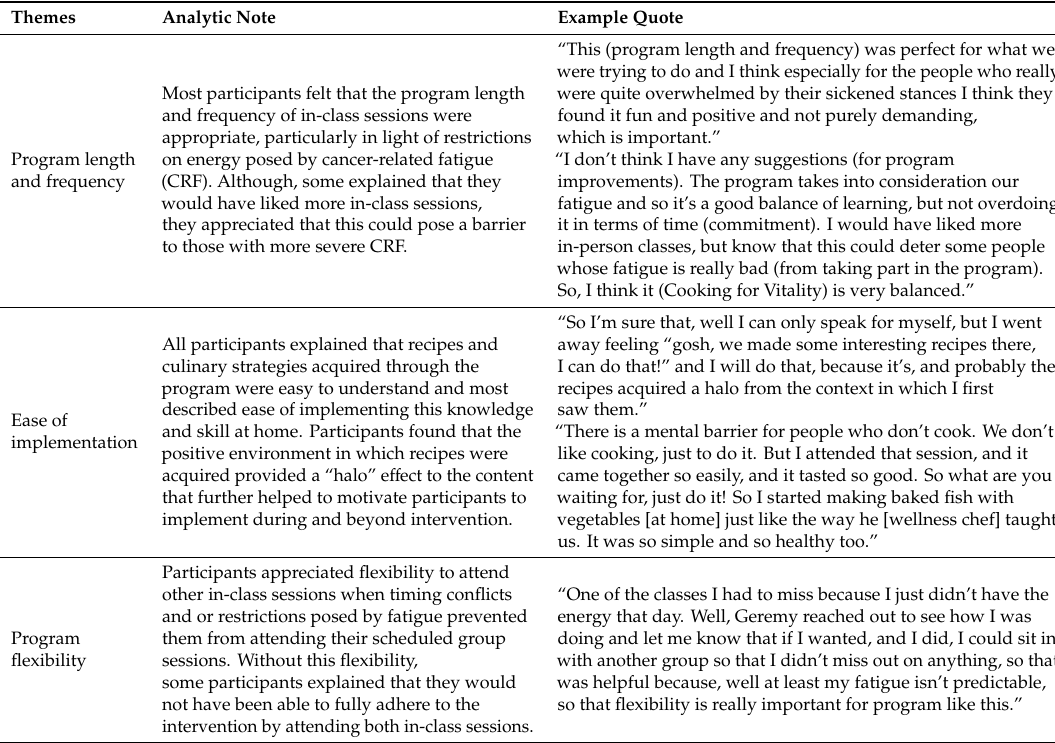
Table 2. Qualitative table for